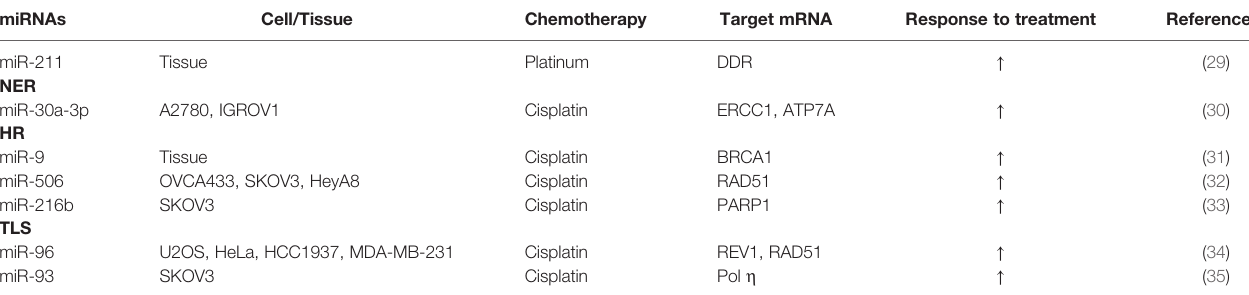
TABLE 2 | Increased DNA repair and miRNAs in